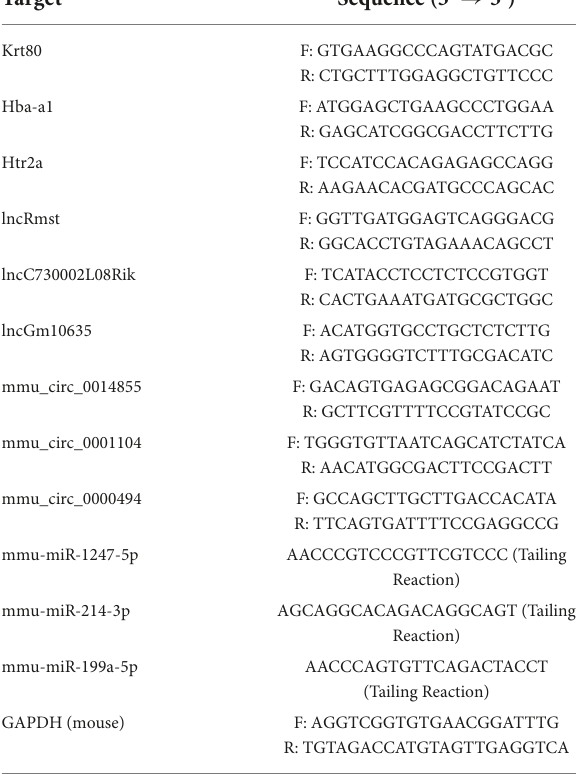
TABLE 1 Quantitative real-time polymerase chain reaction (qRT-PCR) primer